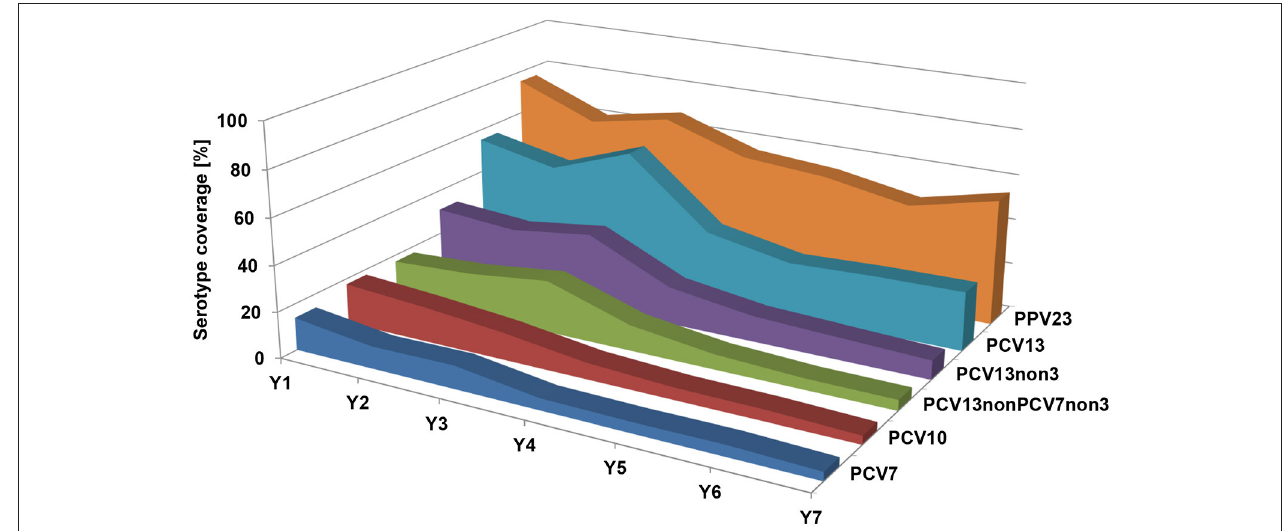
FIGURE 5 | Prevalence of S. pneumoniae serotypes among NPS isolates over the seven study years, grouped by different vaccine formulations. PCV7, serotypes included in PCV7; PCV10, serotypes included in PCV10; PCV13, serotypes included in PCV13; PCV13-non-PCV7-non-3, PCV13 serotypes, excluding PCV7 serotypes and serotype 3; PCV13-non-3, PCV13 serotypes excluding serotype 3; PPV23, serotypes included in PPV23.